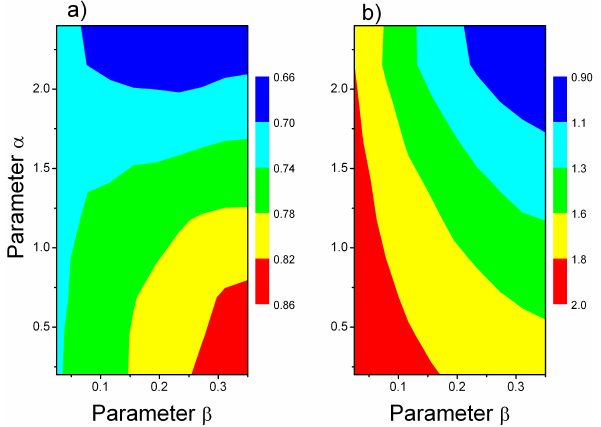
Fig. B2. A family of points where ρ αβ = ρ obs , the corresponding three-parameter polynomial fits and the obtained solution ( α ∗ and β ∗